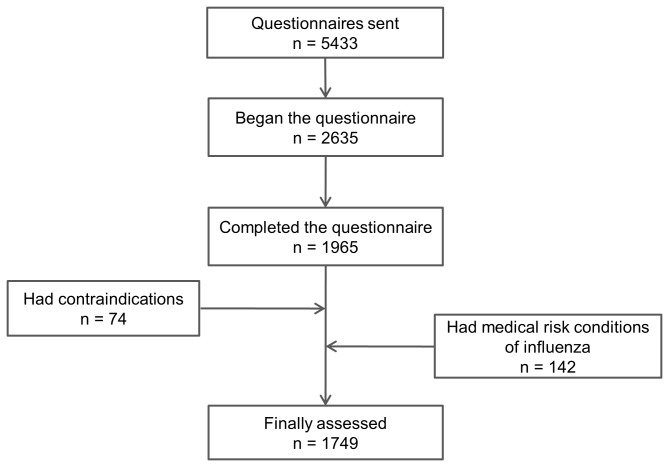
Flowchart of healthcare workers’ questionnaires assessed in the study.